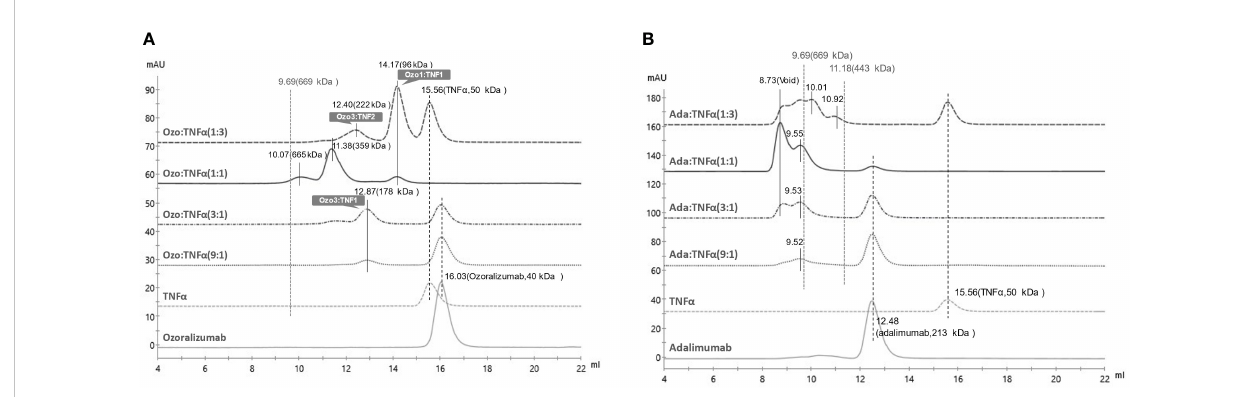
FIGURE 1 Size Exclusion Chromatography (SEC) of immunocomplexes of TNF a with ozoralizumab or adalimumab. (A) chromatograms of ozoralizumab-TNF a mixtures in various molar ratios. (B) chromatograms of adalimumab-TNF a mixtures in various molar ratios. All molecular weights were estimated by calibration with molecular weight